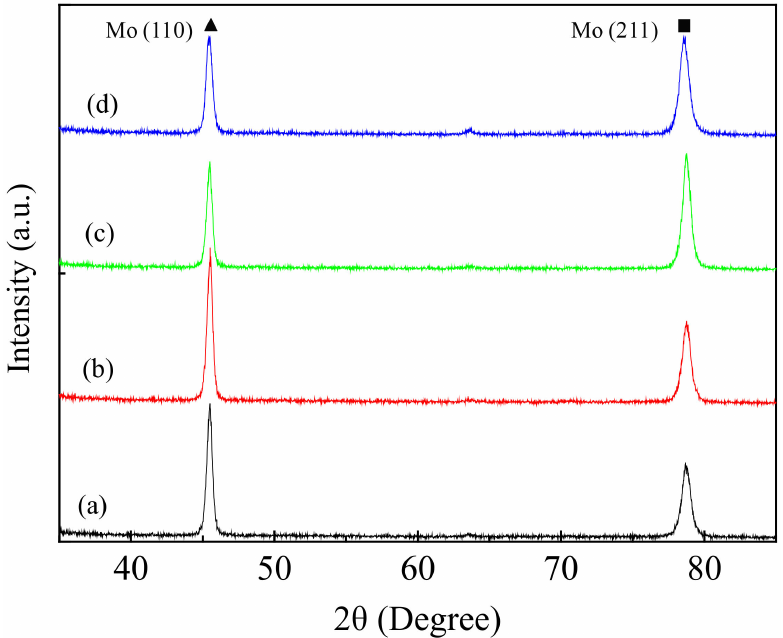
Figure 9. XRD analysis of HiPIMS with different bias voltage of Mo film: ( a ) floating; ( b ) − 20 V; ( c ) − 40 V; ( d ) − 60